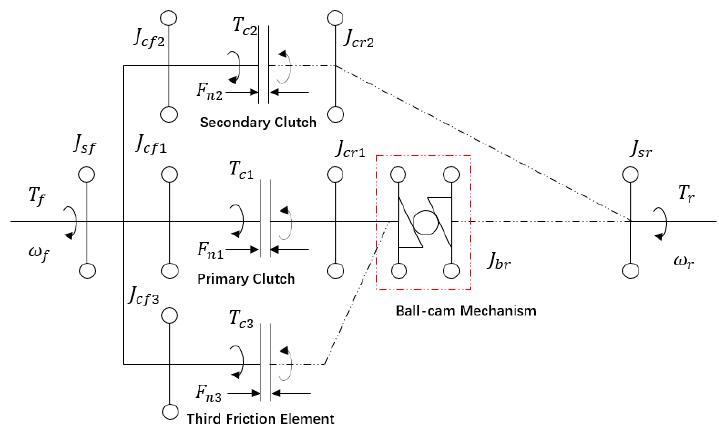
Figure 10. The series and parallel structure of EMTC. T c 1 , T c 2 , T c 3 -the transferred torque by primary clutch, the secondary clutch and the third friction element respectively; F n 1 , F n 2 , F n 3 -the compression force of the three elements; J sf , J sr -the moments of inertia of the input and output shaft; J cf 1,2,3 , J cr 1,2,3 -represent the moments of inertia of the driving and engaged plates of the three elements; J br -the moment of inertia of the ball-cam mechanism.